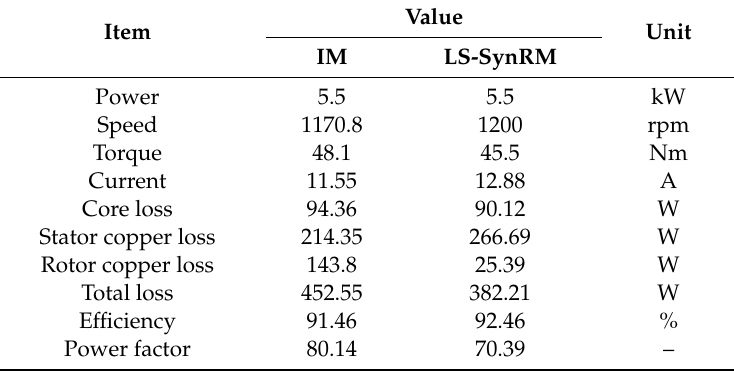
Table 4. Permanent magnet